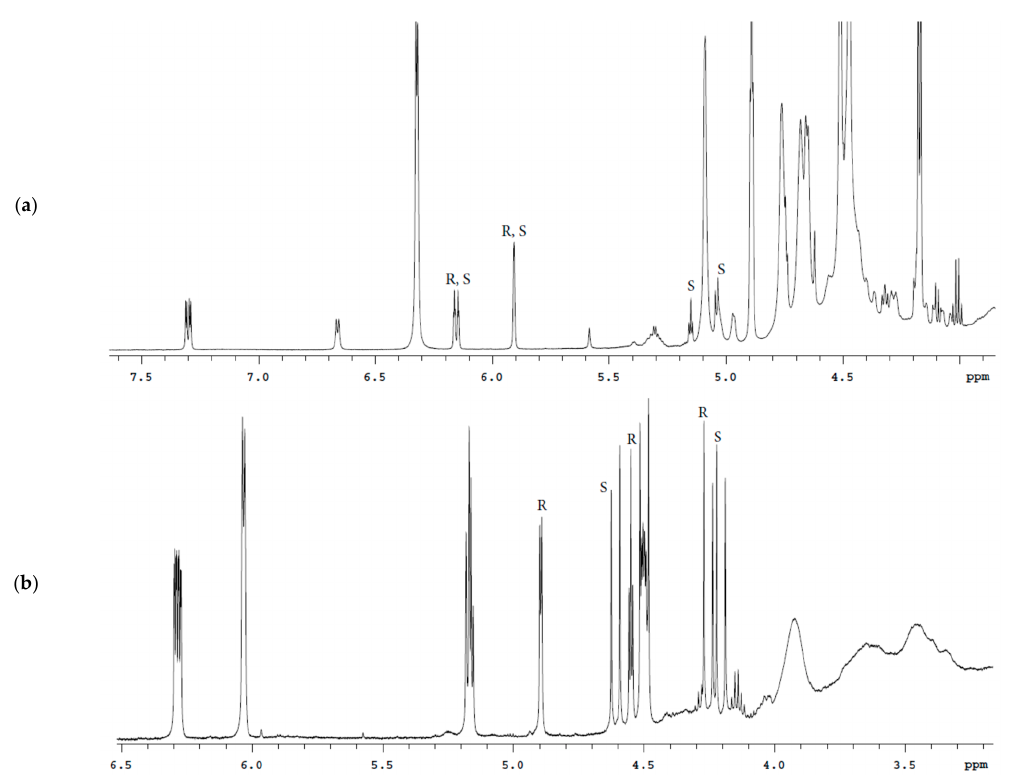
Figure 9. 1 H spectra fragments of the Bud tablets solutions in DMSO-d6 ( a ) and CDCl 3 ( b ) with characteristic signals of 22 R and 22 S epimers.